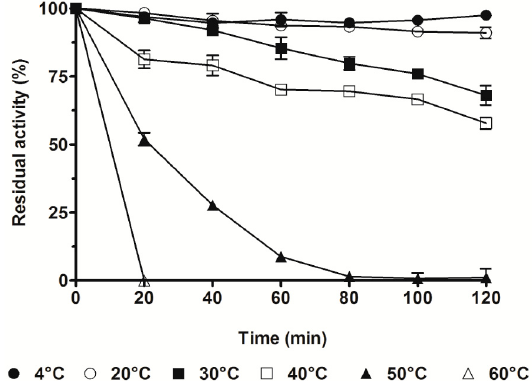
Figure 4. Thermal stability of SpG6PD1. SpG6PD1 enzyme in buffer A was aliquoted and then incubated at 4, 20, 30, 40, 50, and 60 °C for the indicated time, after which SpG6PD1 activity was measured in the reaction mixture with NADP + as a cofactor, at 30 °C for 2 min. The catalytic activity at 30 °C before incubation was considered 100%. Data correspond to the value ± SD of three independent experiments.